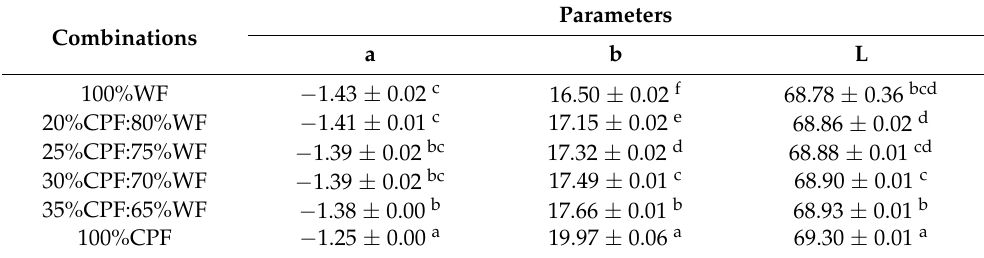
Table 3. Color parameters measurement of durum wheat flour, fortified durum flour, and chickpea flour. Combinations